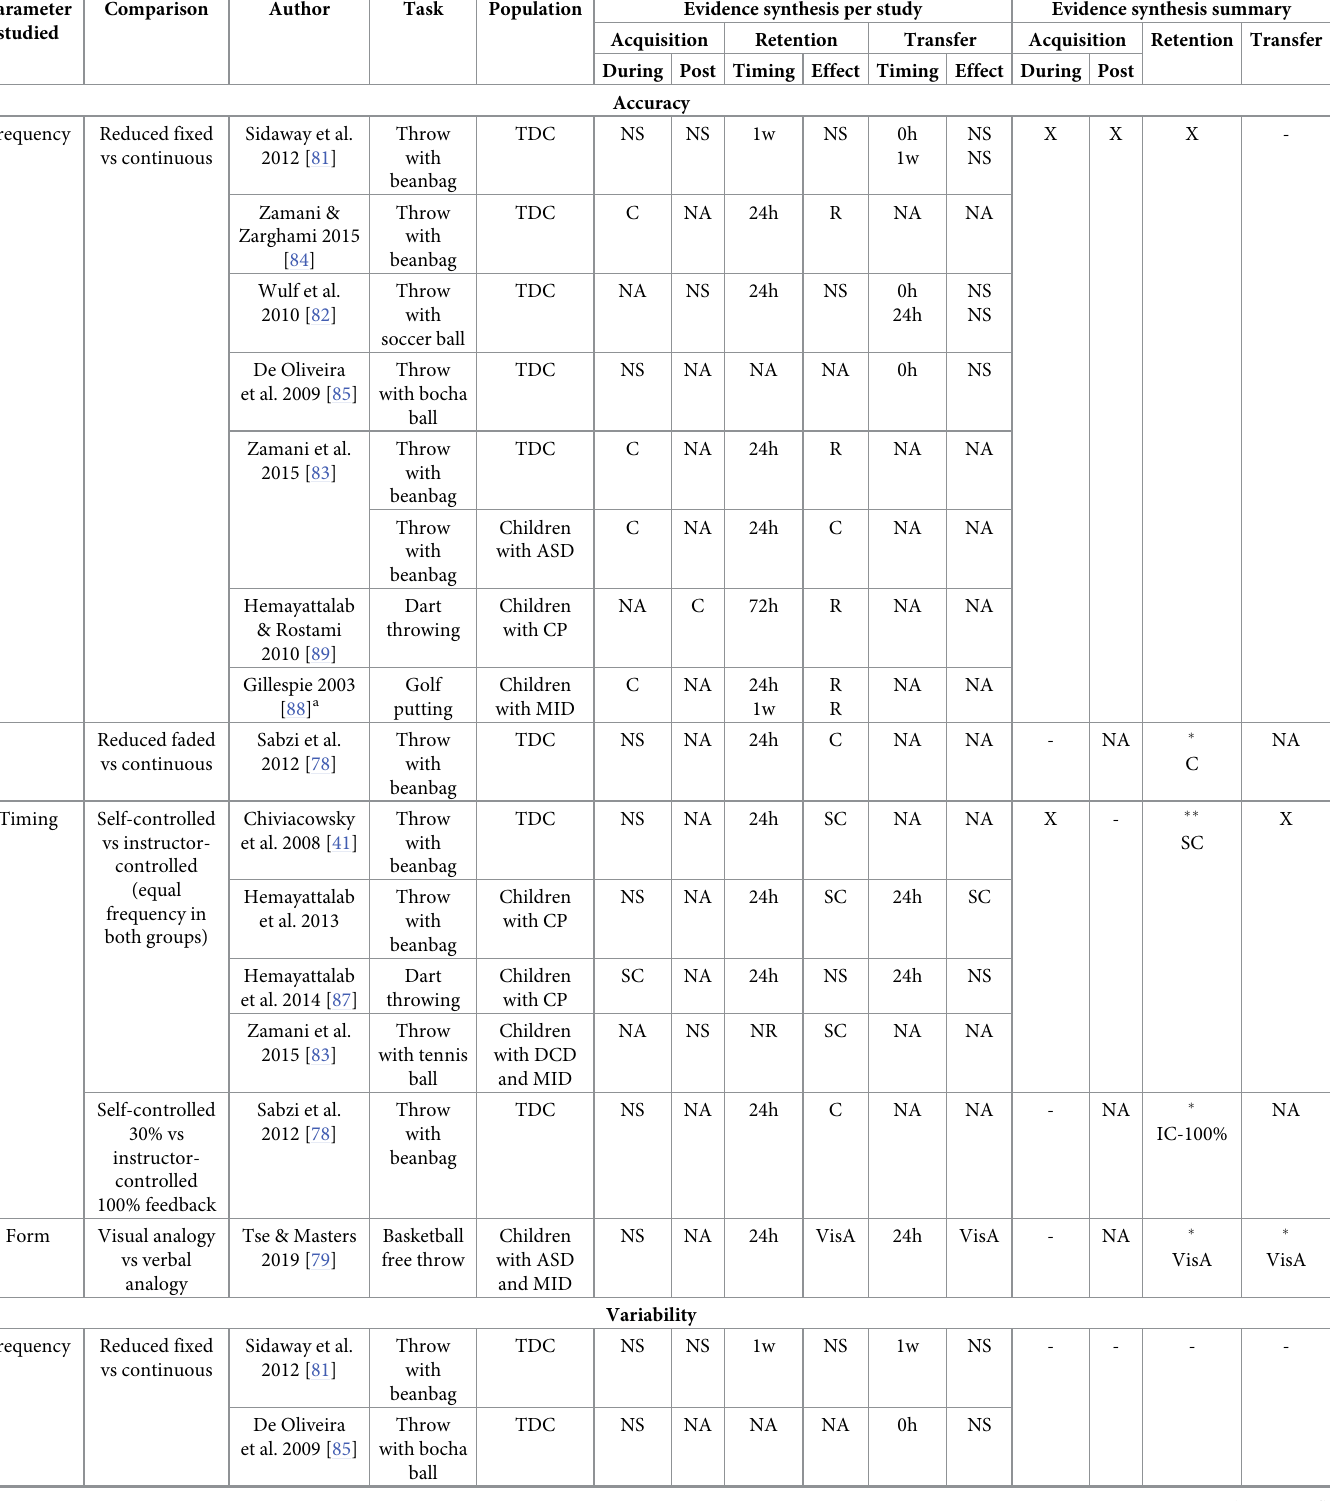
Table 2. Best-evidence synthesis of instructions or feedback applied with a specific frequency, timing or